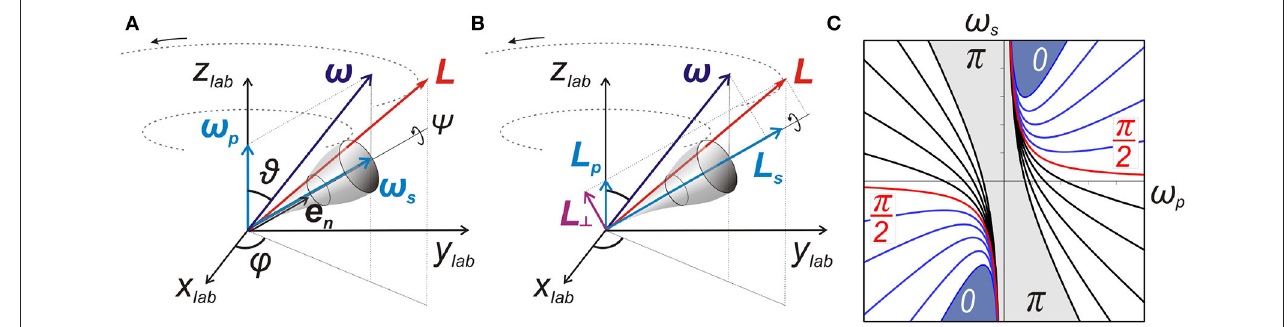
FIGURE 1 | (color online) Precession of a heavy symmetric top. (A) focuses on angular frequencies, while (B) on angular momenta. The index lab specifies the axis of the laboratory (inertial) reference frame. Quantities associated with precession are marked by p , those with spinning by s , and the ones related to the symmetry axis and the principal axes perpendicular to it, by n and ⊥ , respectively. (C) Interdependence of the orientation ϑ , precession ω p , and spin ω s of a heavy top, described by Equation (1). The lines represent constant nutation angle ( ϑ ) curves. Intersections of the curves with a horizontal line show the allowed value(s) for the precession angular frequency ω p . Note that for ϑ ∈ { 0, π } ω p and ω s cannot be distinguished [21].